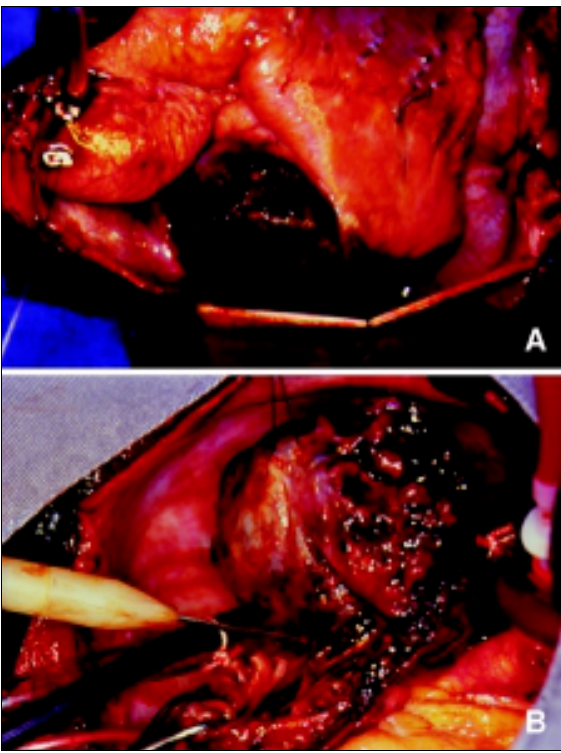
Fig. 1 - Aspecto macroscópico intra-operatório do tumor. A: Antes da abertura do átrio. B: Após abertura do átrio.